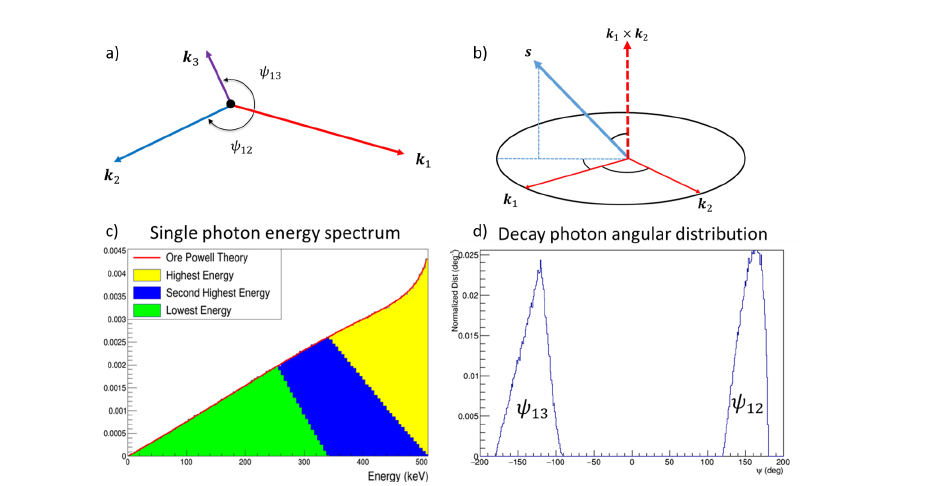
Figure 1. a) Ordering of decay photons by their energies. b) Relevant vectors in o-Ps decay. c) Energy distribution for photons from unpolarized o-Ps. d) Angular distribution of photons within the decay plane for unpolarized